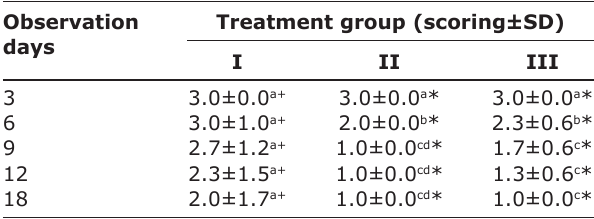
Table-1: Observation of subjective donor skin color